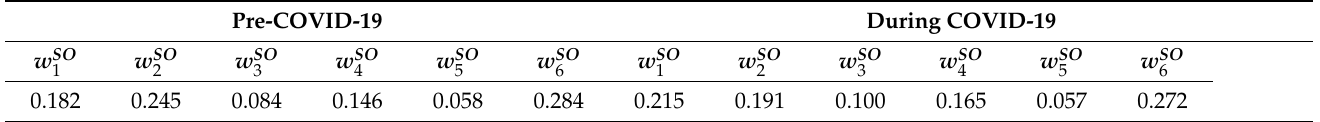
Table 11. The subjective-objective weights of the productivity criteria pre- and during COVID-19. Pre-COVID-19 During